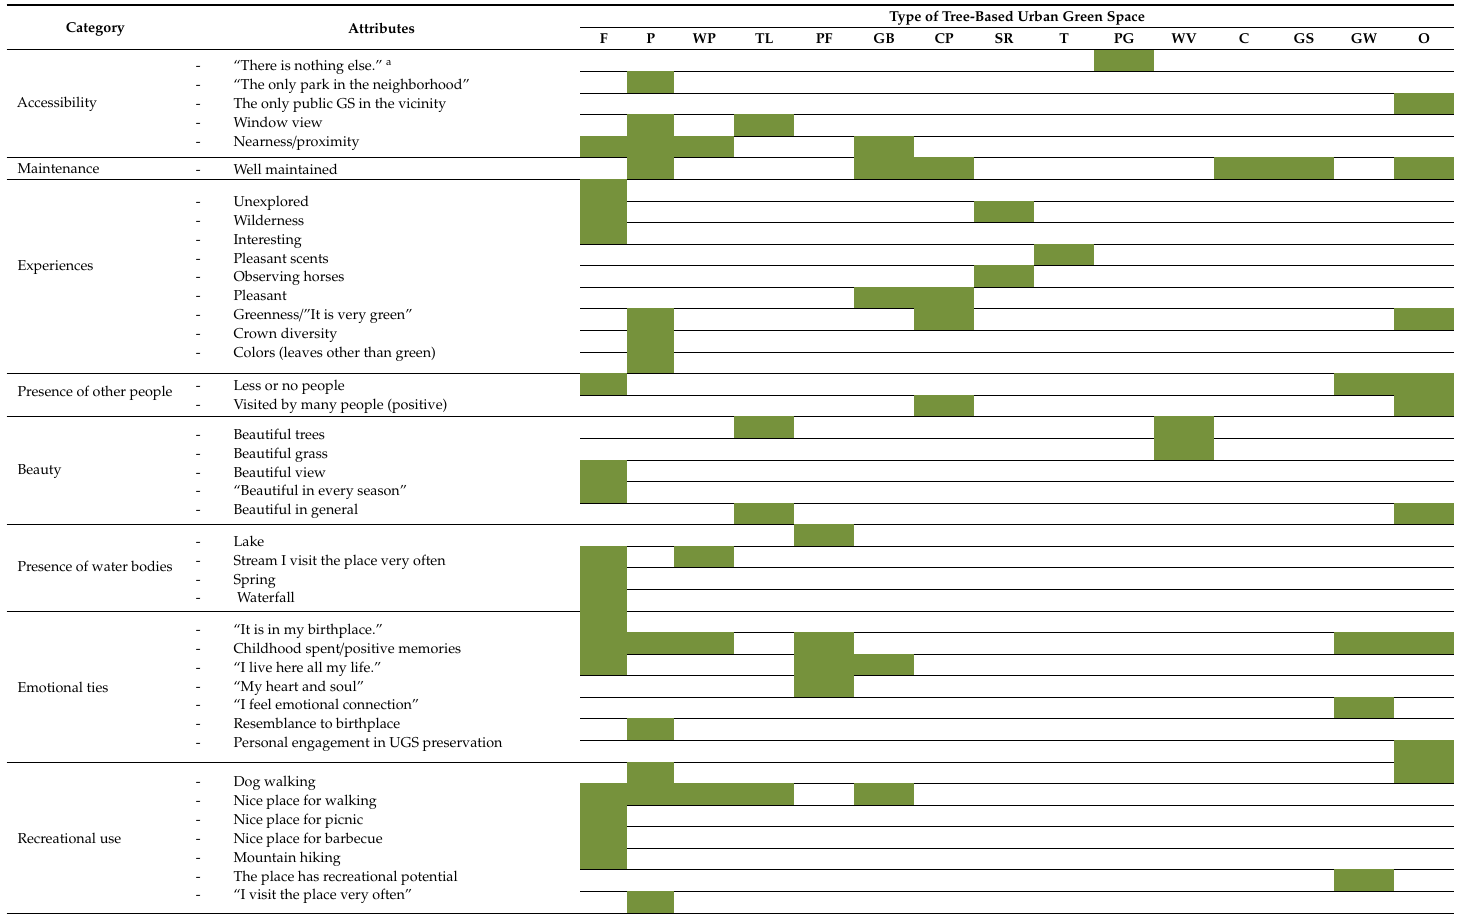
Table 3. Categories and attributes with regard to favorite / dearest tree-based urban green space (UGS). Green indicates the assignation of an attribute to particular type of UGS (F—forest, P—park, WP—walking paths along the streams, TL—tree lines, PF—park forest, GB—greenery around residential buildings, CP—children playgrounds, SR—greenery of sports and recreational facilities, T—trees, PG—private garden, WV—window view, C—cemeteries, GS—green system, GW—greenway, O—other). Quotations refer to verbatim statements of the